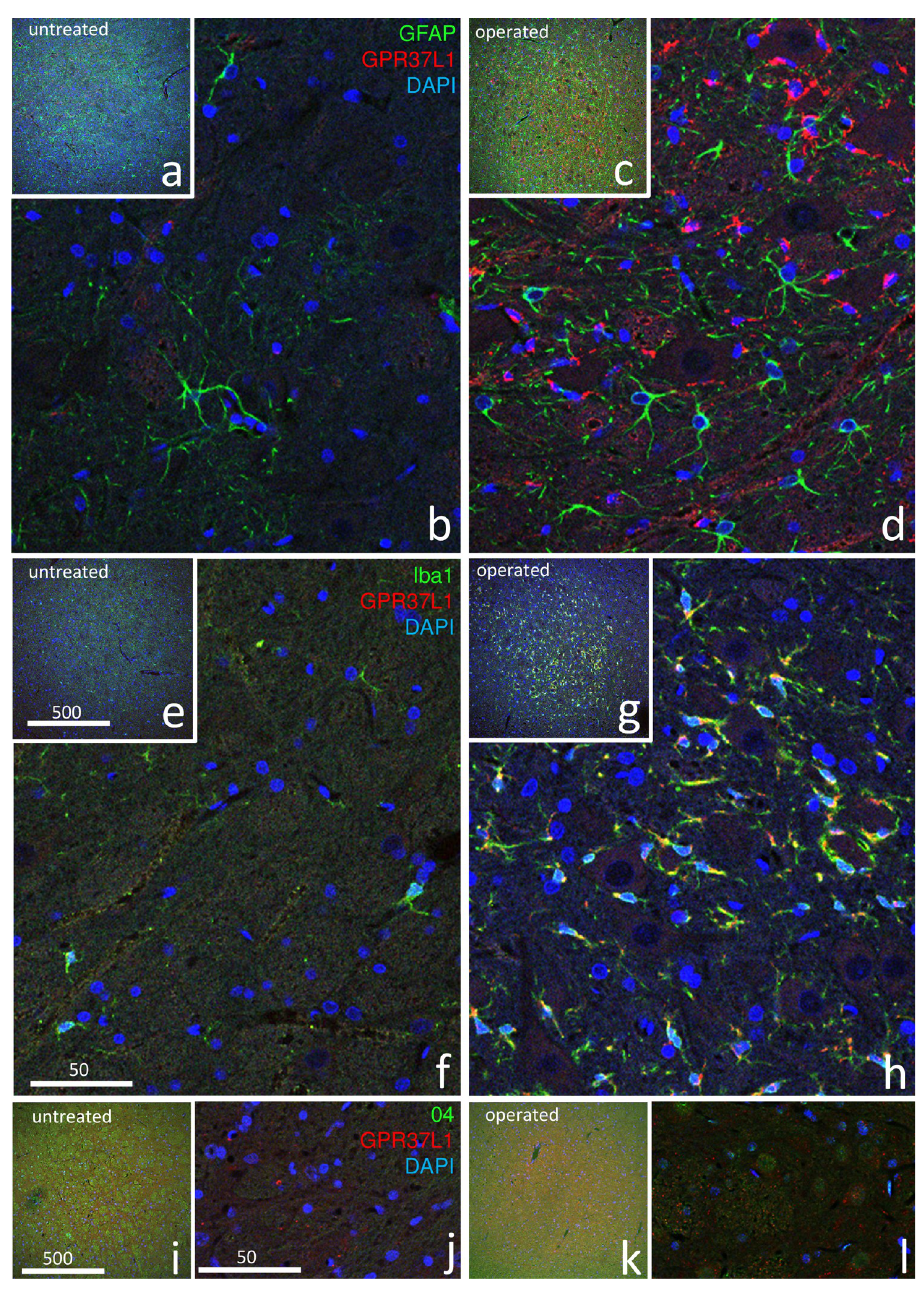
Fig 4. Double-immunofluorescence staining in the facial nucleus 7 days after facial nerve transection. Double- staining images for GPR37L1 (red) with glial markers (GFAP, Iba1, and O4; green) and DAPI (blue) are shown at lower (a, c, e, g, i, k) and higher (b, d, f, h, j, l) magnification. These images show that cells with a high GPR37L1-IR signal were located predominately on the operated side (d, h, l). Double-staining with GPR37L1 and GFAP (a–d) showed that GPR37L1-IR and GFAP-IR increased intensely in the facial nerves on the operated side (c, d), but co- localization of GPR37L1 with GFAP was not evident (d). Double-staining with GPR37L1 and Iba1 (e–h) showed that GPR37L1-IR and Iba1-IR also increased on the operated side (g, h), and high co-localization of GPR37L1 with Iba1 was observed in many cells (h). Double-staining with GPR37L1 and O4 (i–l) showed that GPR37L1-IR increased, but O4-IR cells only increased weakly on the operated side (k, l), and co-localization of GPR37L1 with O4 was not evident (l). The numbers on the bars indicate the scale in microns.